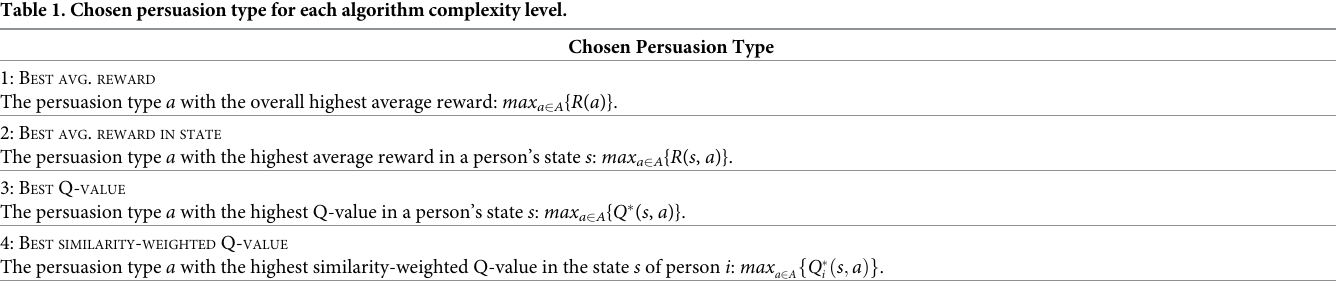
Table 1. Chosen persuasion type for each algorithm complexity level.